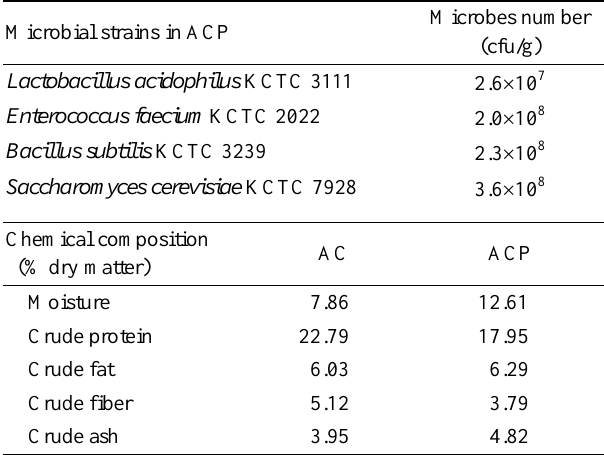
Table 1. The number of microbial strains in ACP and chemical compositions of AC and ACP Microbial strains in ACP